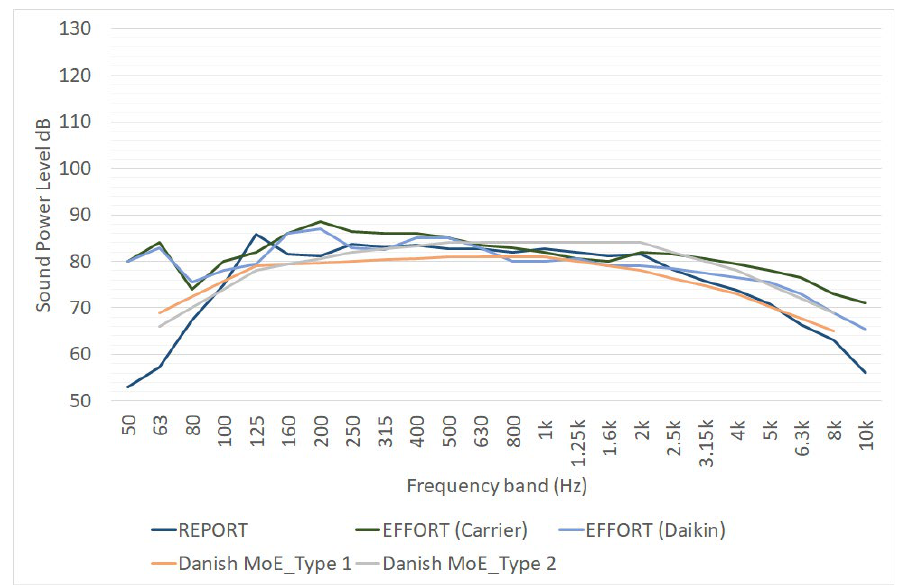
Figure 6. Sound power level spectra of reefers, as defined by REPORT Project [16], EFFORT Project [18] and a report of the Danish Ministry of Environment [25]. L W is expressed in dB for point sources, in dB/m for linear sources and in dB/m 2 for area sources.